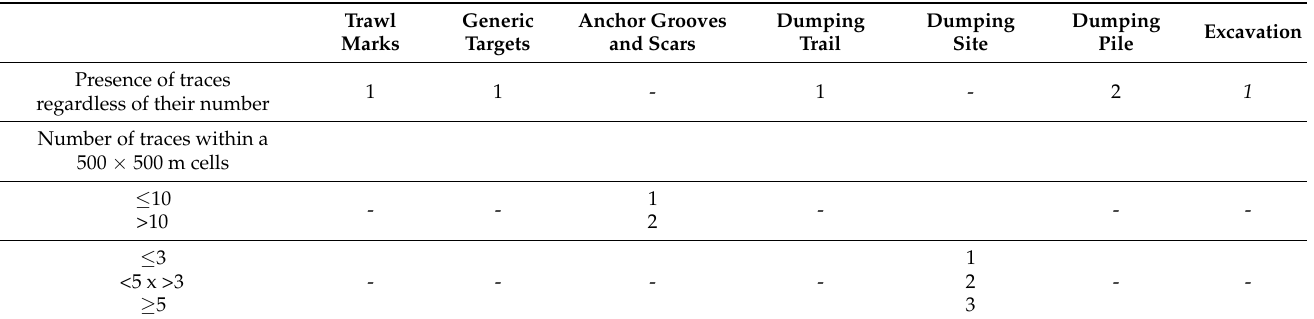
Table 2. Score to grid cell based on the numerical count of physical harm features. Trawl Generic Anchor Grooves Marks Targets and Scars